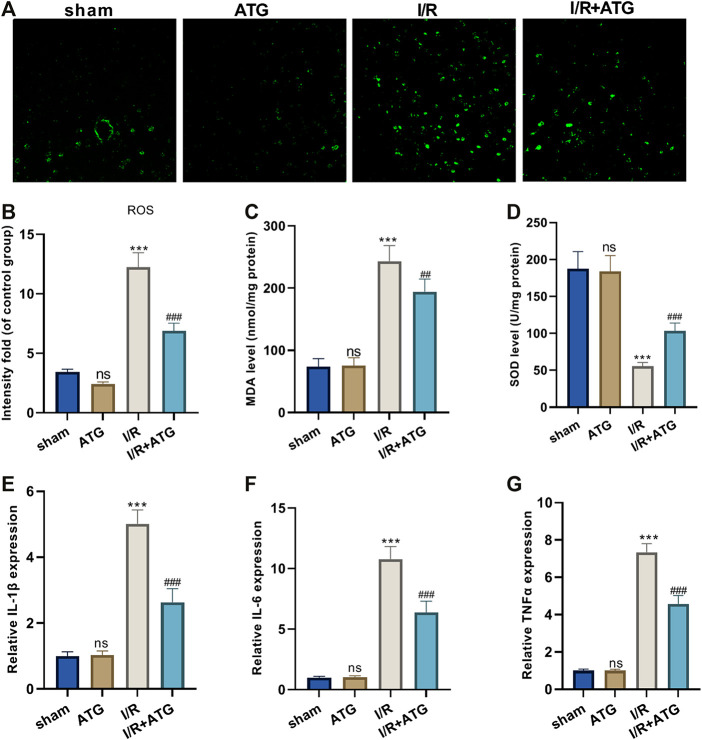
Arctigenin reduced oxidative stress and inflammation in AMI/R rats in vivo. The MI model was constructed, and treated with 100 µmol/kg of Arctigenin. The cardiac tissue was taken on the 21st day after surgery. (A–D) ROS level and the content of oxidative stress markers MDA and SOD in rat myocardium. (E–G) RT-PCR experiment to detect the levels of inflammatory factors IL-6, IL-1β, TNF-α. nsP >0.05, ***p < 0.001 (vs.sham group), ##p < 0.01, ###p < 0.001 (vs.IR group), N = 5.